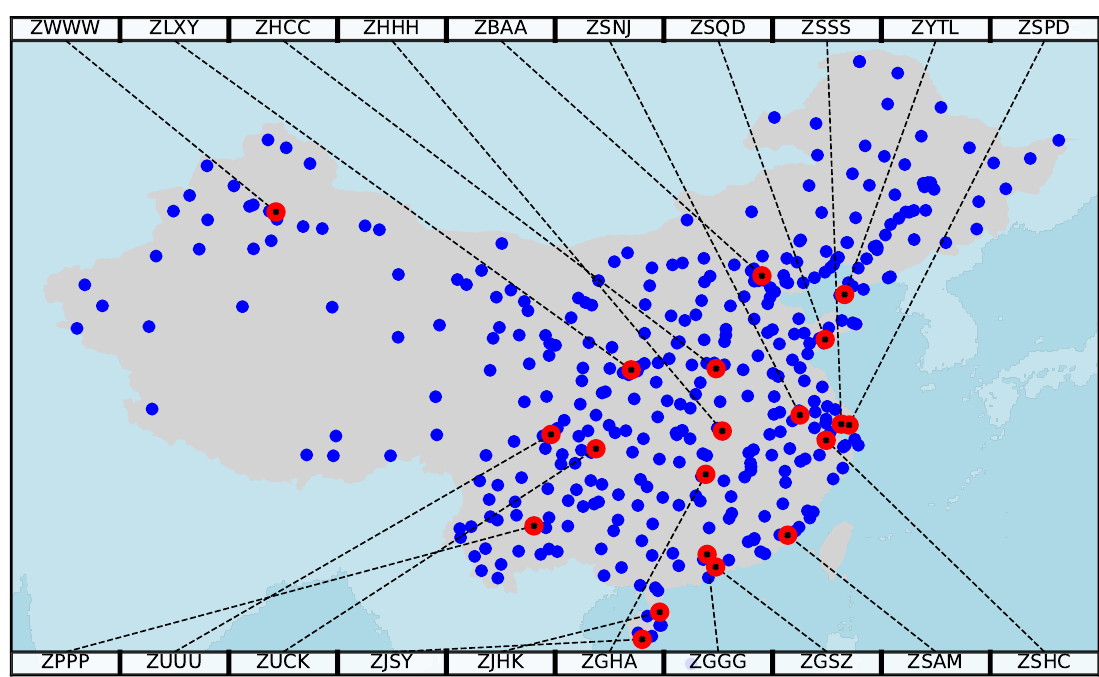
Figure 1. Chinese air transportation infrastructure. All 277 Chinese airports are represented by blue dots. The top 20 Chinese airports according to the total number of passengers are highlighted and labeled with their four-character ICAO codes.